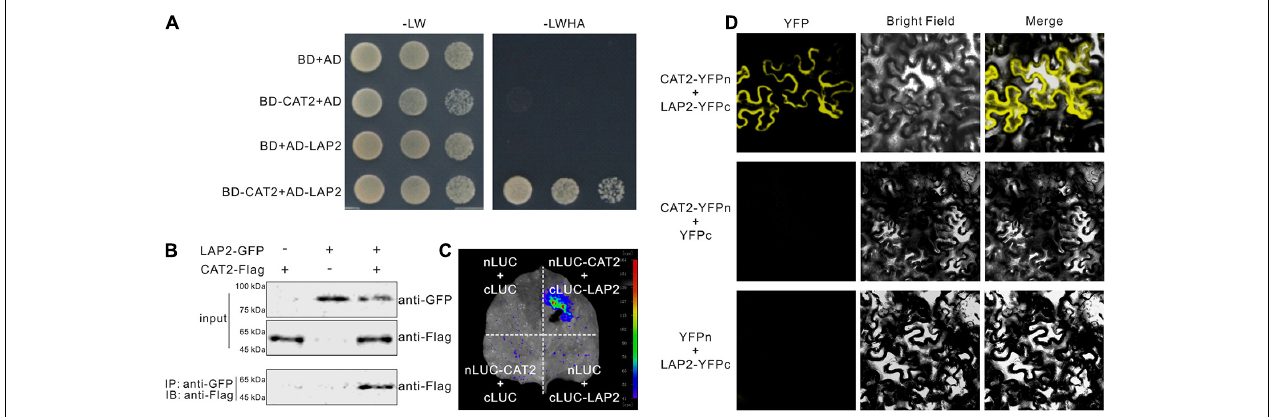
FIGURE 1 | CAT2 interacts with leucine aminopeptidase 2 ( LAP2 ). (A) The interaction between CAT2 and LAP2 was examined by yeast two-hybrid experiment. (B) Co-IP assays showing CAT2 – LAP2 interaction. 35S: LAP2 -GFP and 35S: CAT2 -Flag were co-expressed in Nicotiana benthamiana leaves for 3 days via Agrobacterium -mediated transformation. Total proteins were extracted and immunoprecipitated with anti-GFP antibody, and the precipitants were then immunoblotted with anti-Flag. (C) CAT2 interacts with LAP2 in N. benthamiana leaves by the LCI assay. (D) CAT2 interacts with LAP2 in N. benthamiana leaves as indicated by BiFC